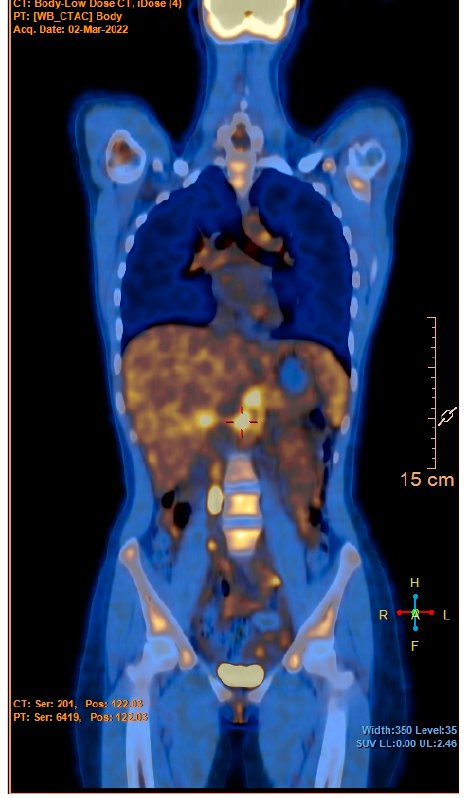
Figure 3. PET-CT. Increased metabolic activity of the suprarenal abdominal aorta.